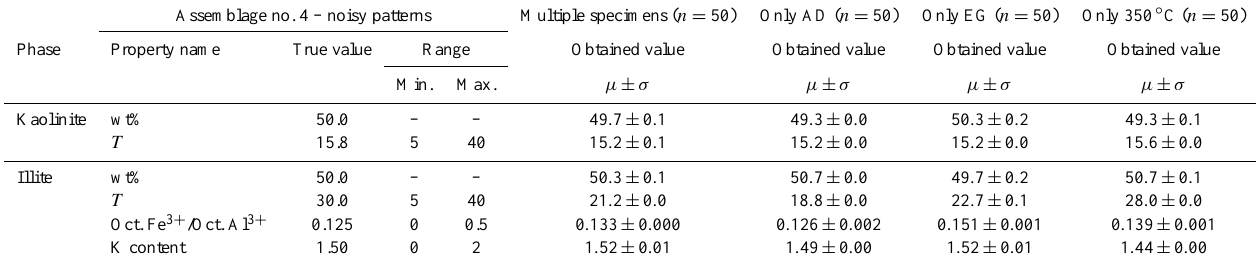
Table 10. Overview of the means and standard deviations of weight fractions and refined parameters for assemblage 4. Assemblage no. 4 – noisy